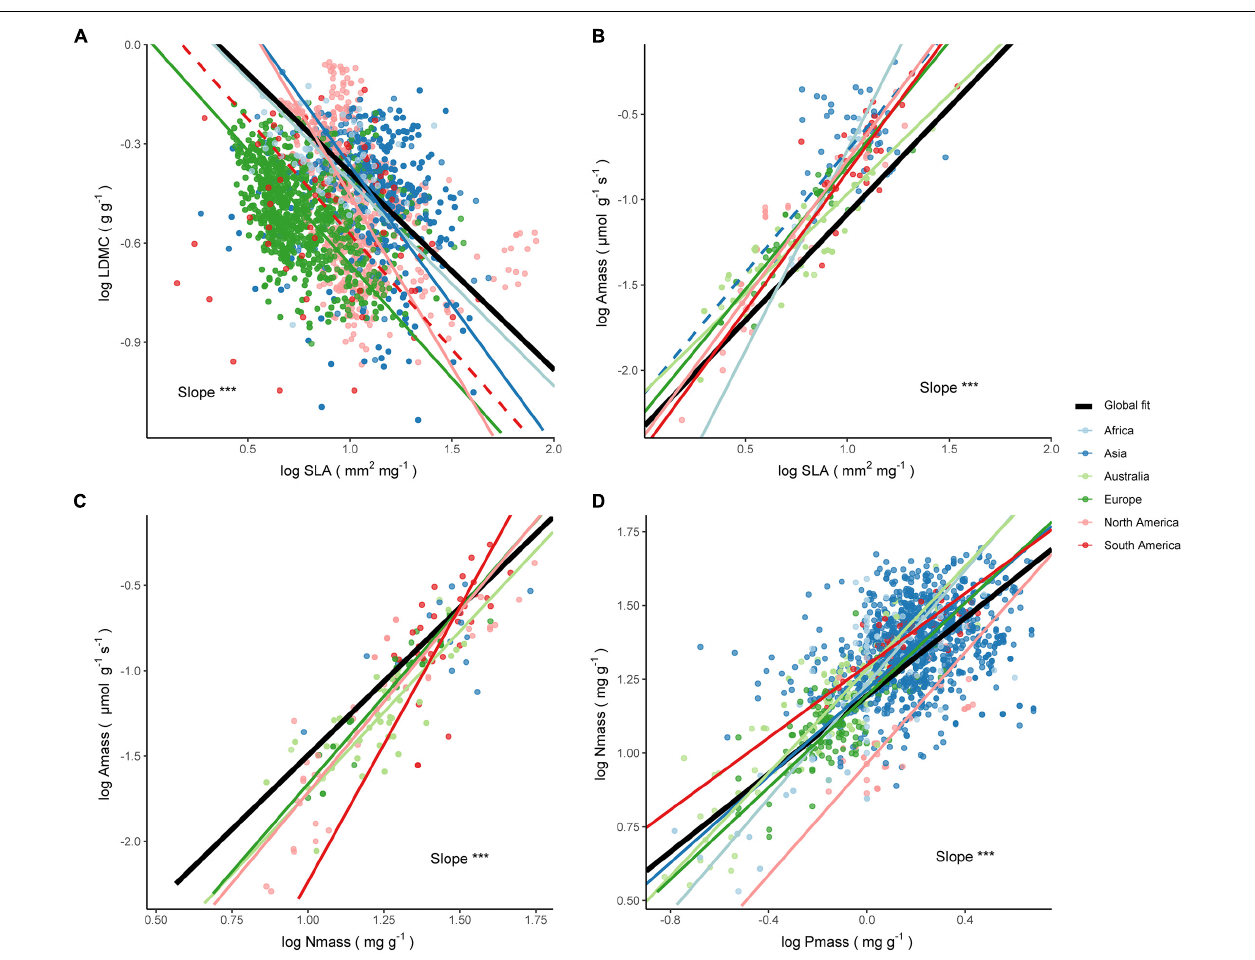
FIGURE 4 | Relationships between leaf economic traits across species within the BS climate. The significance test results of the slope heterogeneity among the fitted lines are shown (*** P < 0.001). The solid line is a significant fit to the standardized major axis (SMA) regression within a continent ( P < 0.05), while insignificant relationships are shown as dashed lines ( P > 0.05). Black solid lines are SMA regression lines for all species on a global scale. The respective slopes, sample sizes, and coefficients of determination of the SMA regressions are as follows (all P < 0.001 unless noted): (A) LDMC–SLA relationship. Africa: b = − 0.62, n = 64, R 2 = 0.06; Asia: b = − 0.84, n = 1048, R 2 = 0.03, P = 0.04; Europe: b = − 0.69, n = 1623, R 2 = 0.18; North America: b = − 1.03, n = 740, R 2 = 0.22; South America: b = − 0.7, n = 68, R 2 = 0.02, P = 0.29. (B) A mass –SLA relationship. Africa: b = 2.35, n = 14, R 2 = 0.95; Asia: b = 1.43, n = 42, R 2 = 0.03, P = 0.27; Australia: b = 1.16, n = 122, R 2 = 0.71; Europe: b = 1.45, n = 46, R 2 = 0.86; North America: b = 1.62, n = 42, R 2 = 0.83; South America: b = 1.62, n = 30, R 2 = 0.46. (C) A mass –N mass relationship. Asia: b = 1.42, n = 16, R 2 = 0.39, P = 0.01; Australia: b = 1.89, n = 123, R 2 = 0.58; Europe: b = 2.05, n = 40, R 2 = 0.89; North America: b = 2.12, n = 47, R 2 = 0.77; South America: b = 3.22, n = 32, R 2 = 0.68. (D) N mass –P mass relationship. Africa: b = 0.97, n = 98, R 2 = 0.62; Asia: b = 0.73, n = 1128, R 2 = 0.11; Australia: b = 0.88, n = 190, R 2 = 0.69; Europe: b = 0.78, n = 123, R 2 = 0.53; North America: b = 0.94, n = 37, R 2 = 0.45; South America: b = 0.61, n = 49, R 2 =